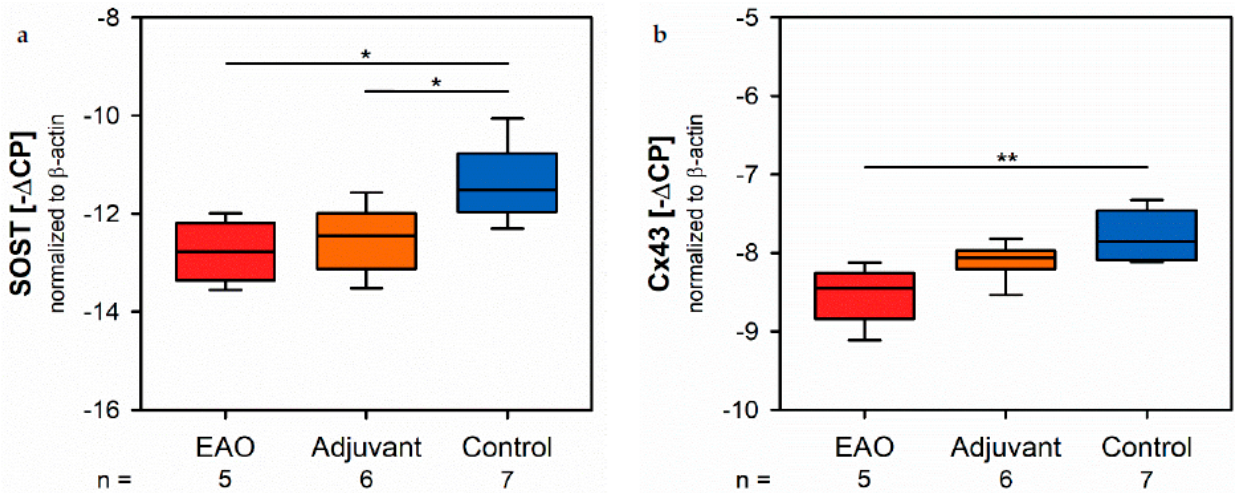
Figure 11. Osteocytes and cell-contacts. mRNA expression of ( a ) sclerostin (SOST) and ( b ) connexin 43 (Cx43) in real-time RT-PCR of vertebral bodies Th10. Mice were immunized with testicular homogenate in adjuvant (EAO), adjuvant alone (adjuvant) or remained untreated (control). * p < 0.05; ** p < 0.01.